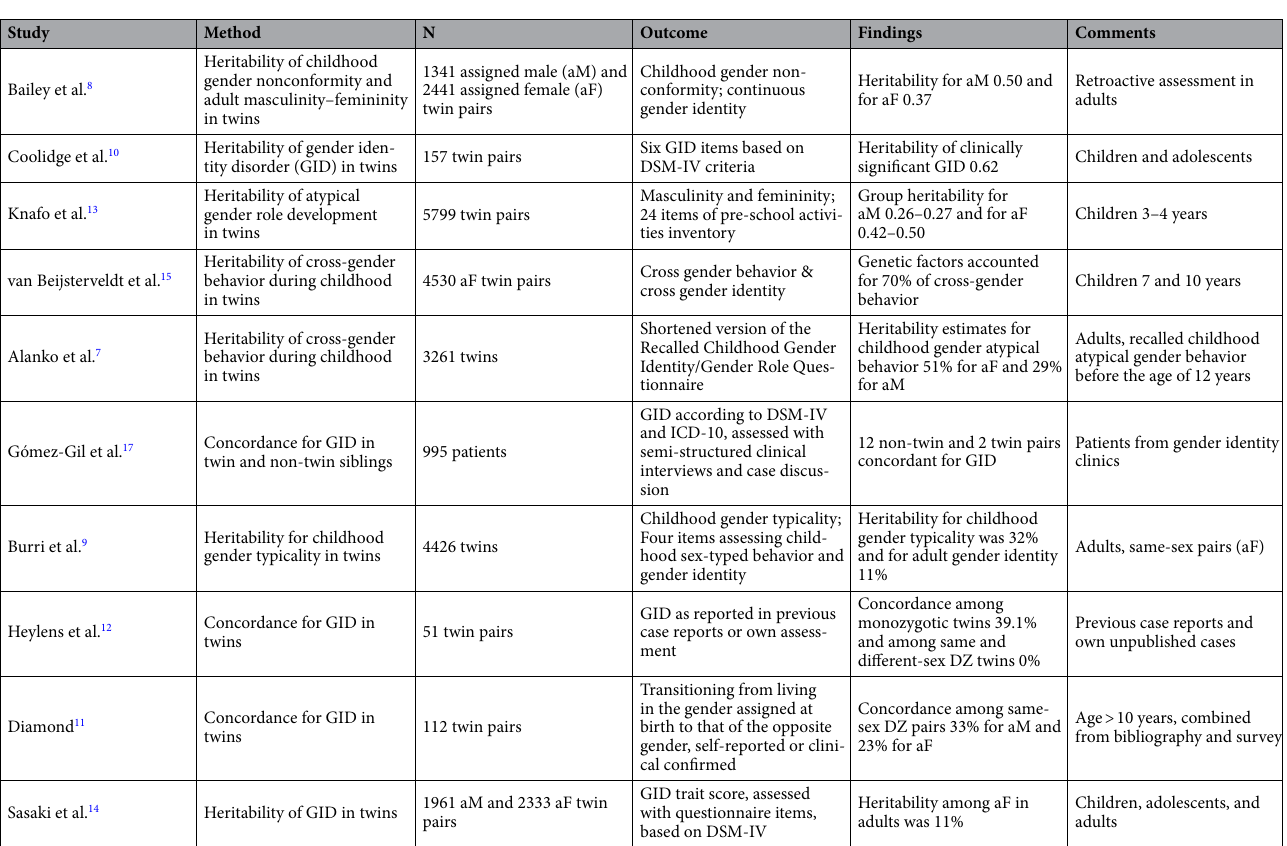
Table 3. Previous studies examining gender identity-related outcomes in twin and non-twin